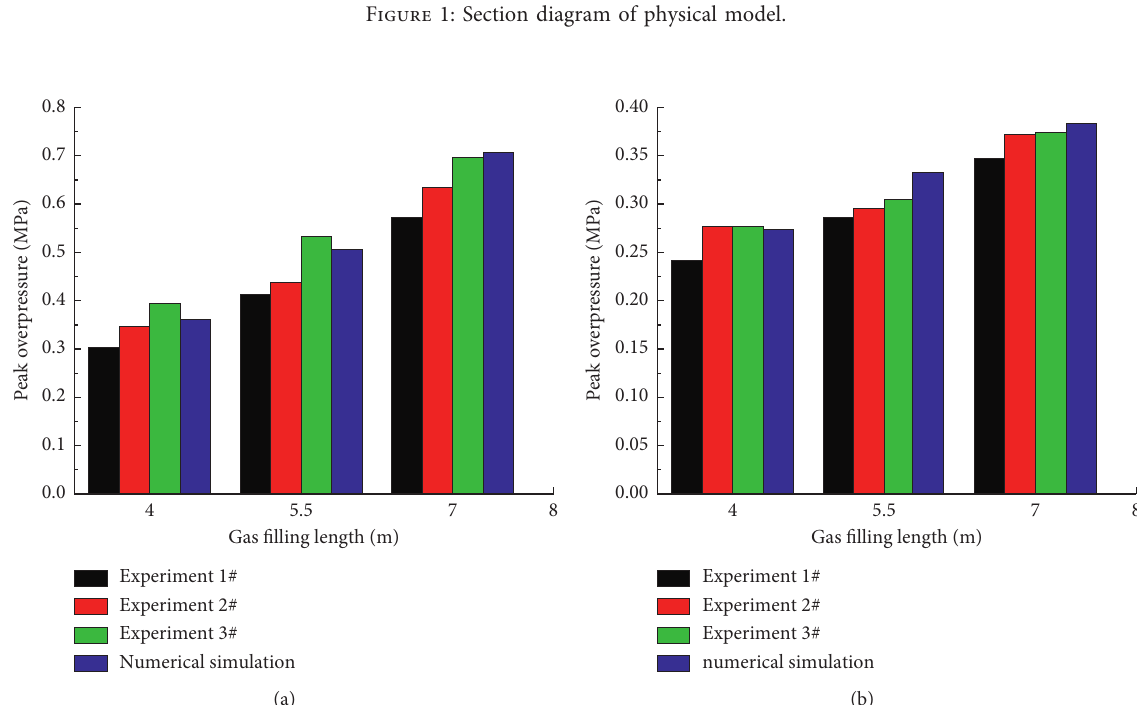
Figure 2: Comparison of CFD simulation and lab experiments results: (a) measuring point 1; (b) measuring point